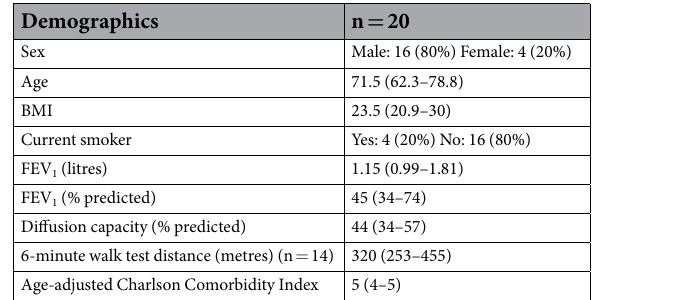
Table 1. All data are median